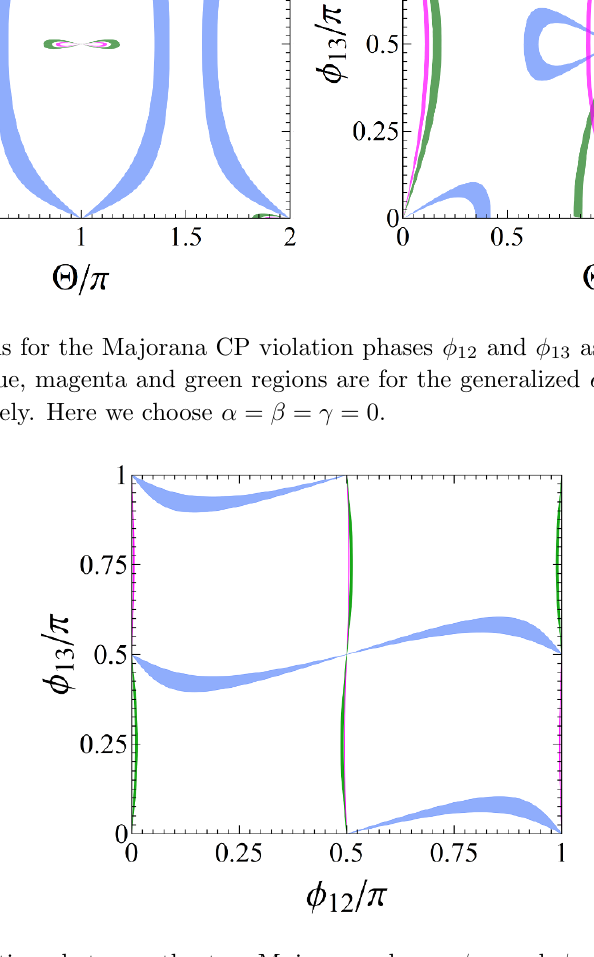
Figure 10 . Correlations between the two Majorana phases (cid:30) 12 and (cid:30) 13 of the lepton mixing matrix. The light blue, magenta and green regions are for the generalized e (cid:0) (cid:22) , e (cid:0) (cid:28) and (cid:22) (cid:0) (cid:28) symmetries respectively. The magenta regions are quite narrow and hardly visible, and they are closely distributed around (cid:30) 12 (cid:24) 0, (cid:30) 12 (cid:24) (cid:25)= 2 and (cid:30) 12 (cid:24) (cid:25) . Here we take (cid:11) = (cid:12) = (cid:13) = 0 for